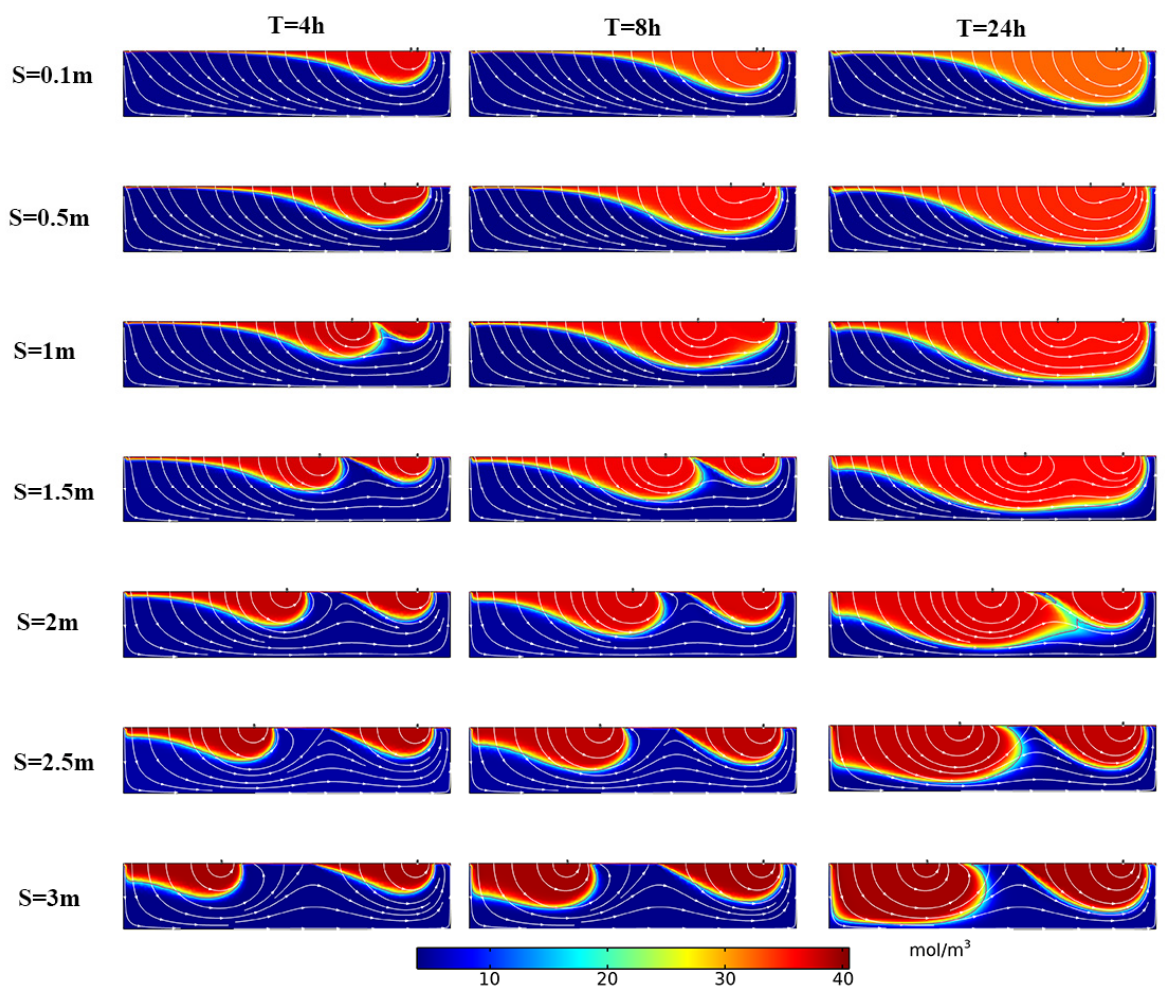
Figure 7. Distribution of solute concentration in the hyporheic zone under the influence of different structural spacings. S represents the distance between structures, T represents time. The color scale for the outputs, representing solute concentration; warmer colors: higher concentration, cooler colors: lower concentration. Flow in the overlying water column (not shown) is from left to right.